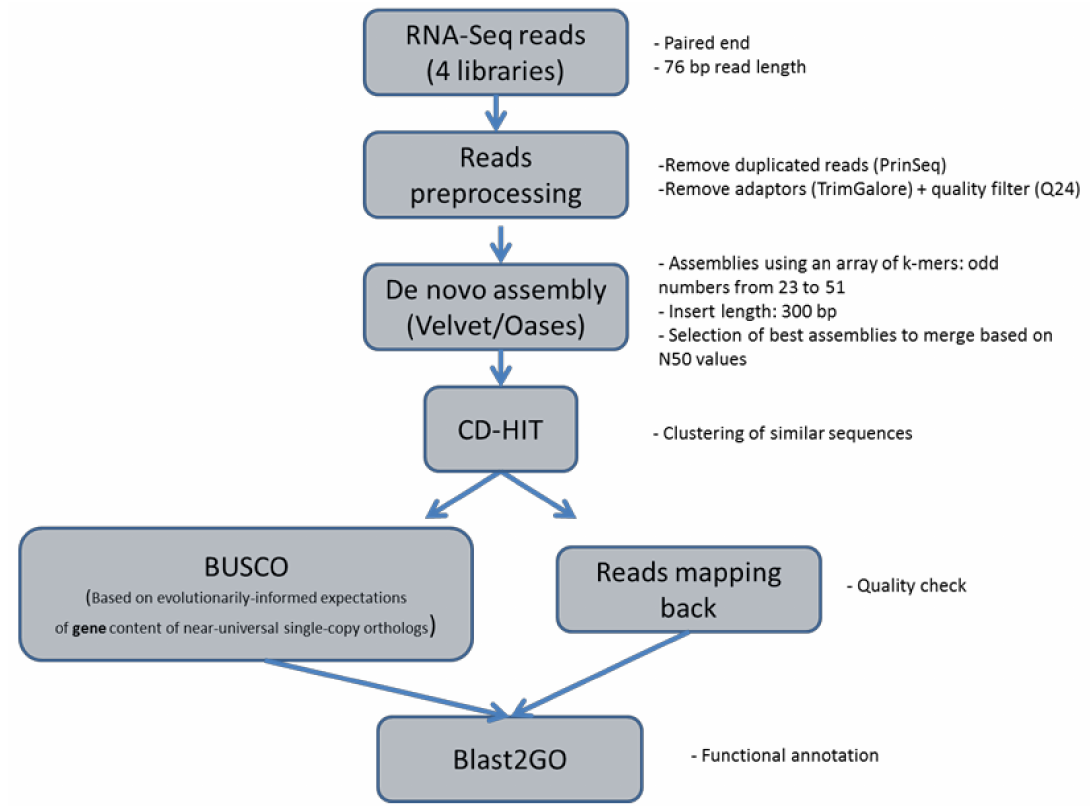
Figure 1. Bioinformatics pipeline used for transcriptome de novo